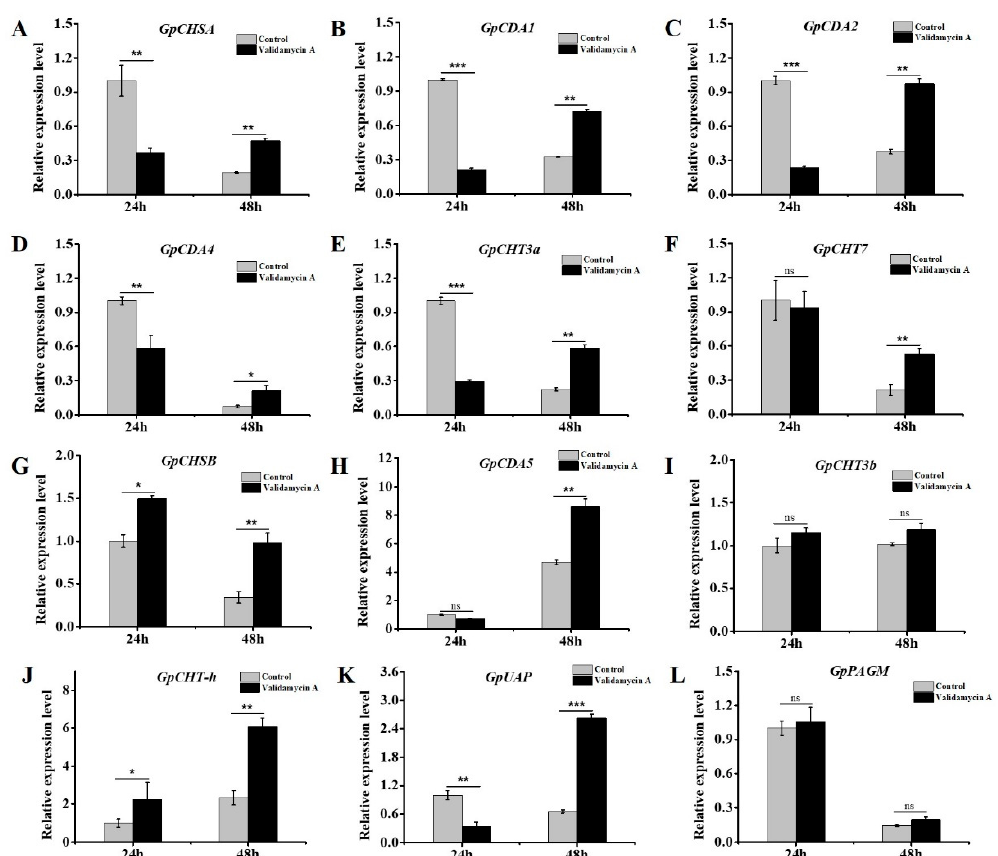
Figure 10. Analysis of the expressions of genes involved in the chitin metabolism pathway 24 h and 48 h after Validamycin A treatment by RT-qPCR. ( A – F ) Six genes involved in the integument pathway, ( G – J ) four genes involved in the midgut pathway, ( K , L ) and two key enzyme genes involved in chitin metabolism. The control group was injected with ddH 2 O. Data are shown as the mean ± SE of three biological replicates. Differences between Validamycin A and control group in ( B , C ) were compared using Mann–Whitney test, and others were compared using t -test. Asterisks above the bars indicated significant differences (* p < 0.05; ** p < 0.01; *** p < 0.001; ns, no significance difference).